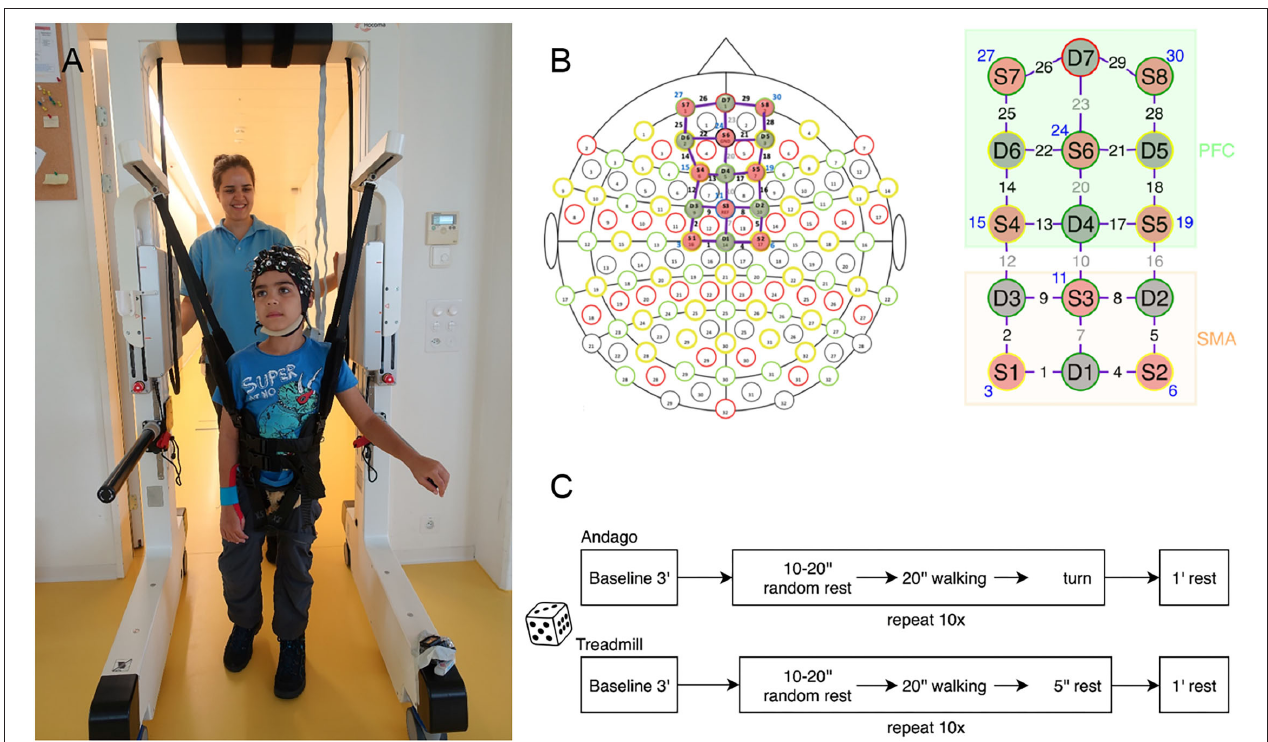
FIGURE 1 | General methodology. (A) Young participant walking in the Andago wearing the fNIRS cap. We mounted the Notebook for data-capturing on top of the Andago. (B) We configured the optodes to cover the Supplementary Motor Area (SMA) and the Prefrontal Cortex (PFC). Of the 30 channels, eight channels were short channels (displayed in blue). Six channels covered the SMA, 10 channels the PFC. (C) Randomization decided whether the participant started with the Andago or the treadmill condition. After the initial baseline measurement, the participants walked 10 times in each condition. To avoid anticipatory effects, they started walking after a rest that varied randomly between 10 and